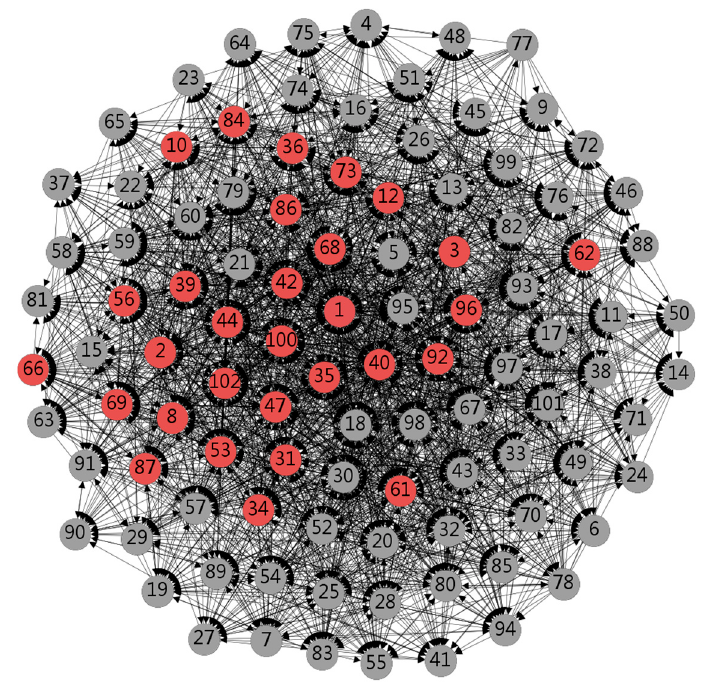
Figure 2. Doctor information interactive network core–periphery structure. Int. J. Environ. Res. Public Health 2019 , 16 , x FOR PEER REVIEW